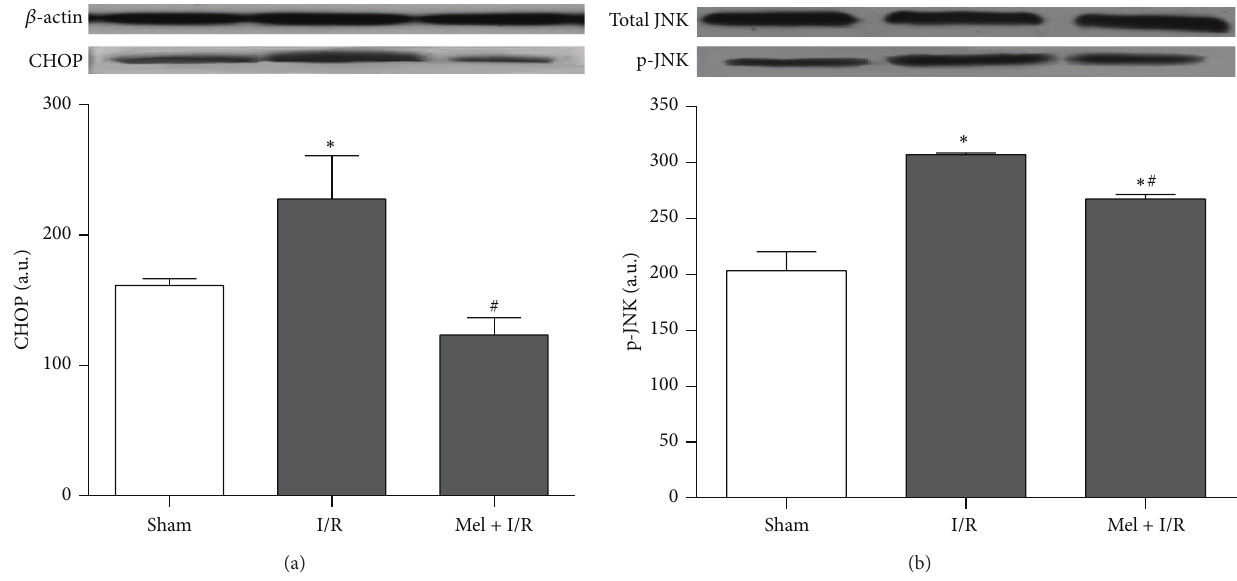
Figure 4: Western blot of CHOP (a) and total and phosphorylated JNK (b). The 𝛽 -actin was used as a loading control. One representative blot of six independent experiments is shown at the top whereas densitometric analysis is shown at the bottom. Results are expressed as mean ± SEM. ∗ 𝑝 < 0.05 versus Sham. # 𝑝 < 0.05 versus I/R.